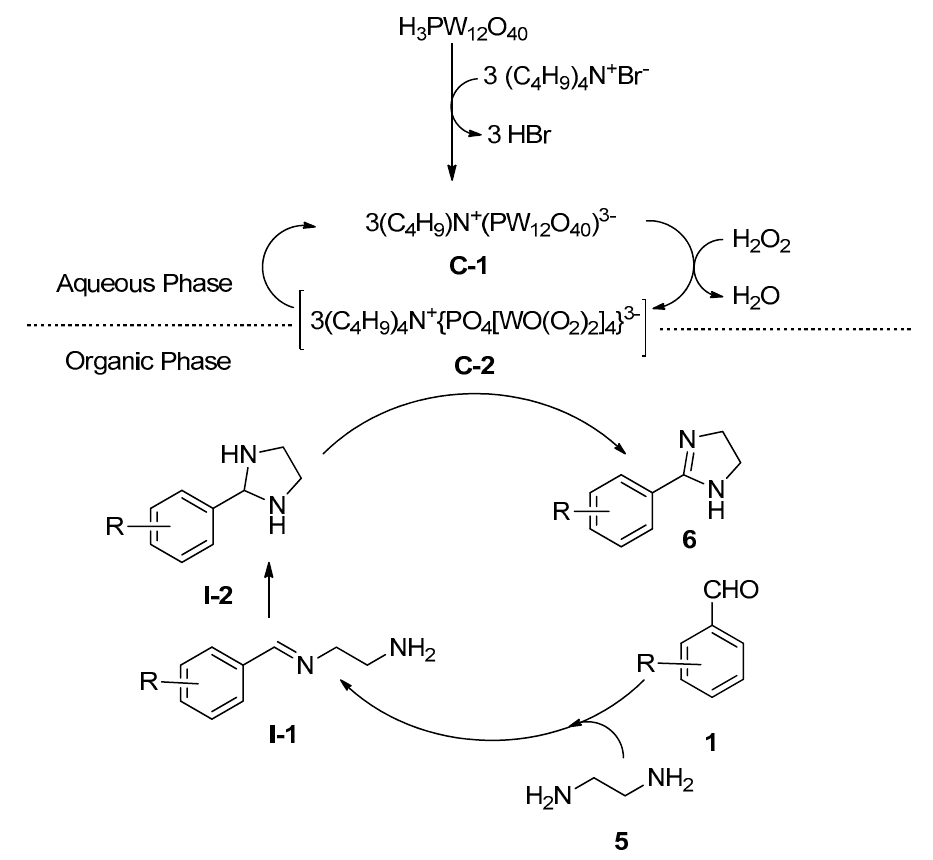
Scheme 3. Plausible role of tungstophosphoric acid and TBAB as an efficient combined phase- transfer catalytic system for the synthesis of 2-substituted imidazolines in